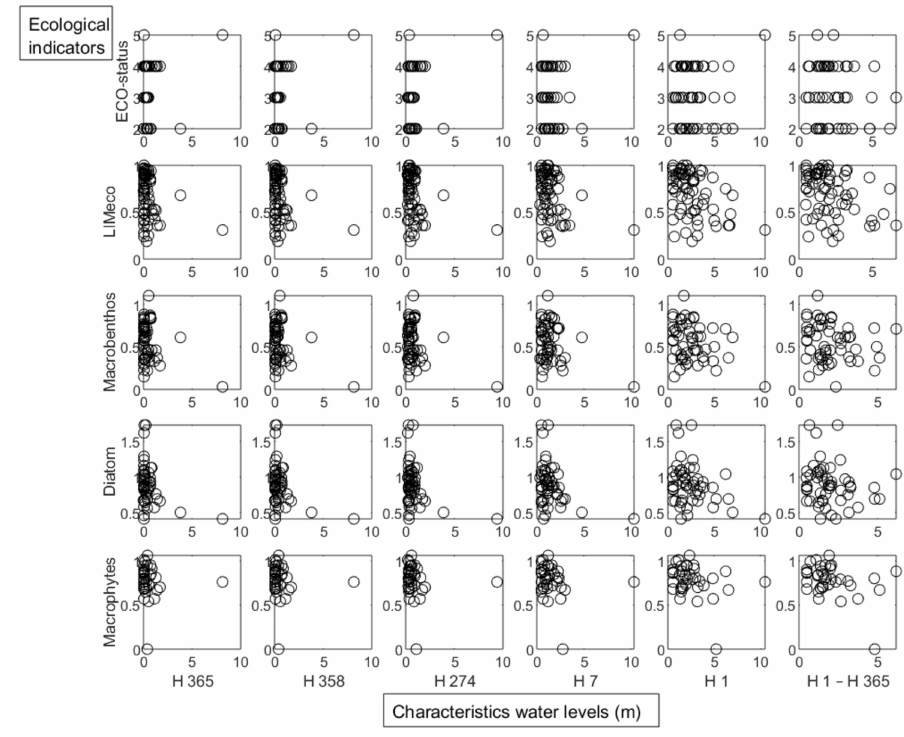
Figure 3. Scatter plots of ecological indicators versus characteristic water levels. Table 1. Pearson’s correlation coefficient r for all ecological and hydrological indicators. Blue cells show higher correlation values between ecological and hydrological indicators, orange cells show the higher correlations among ecological